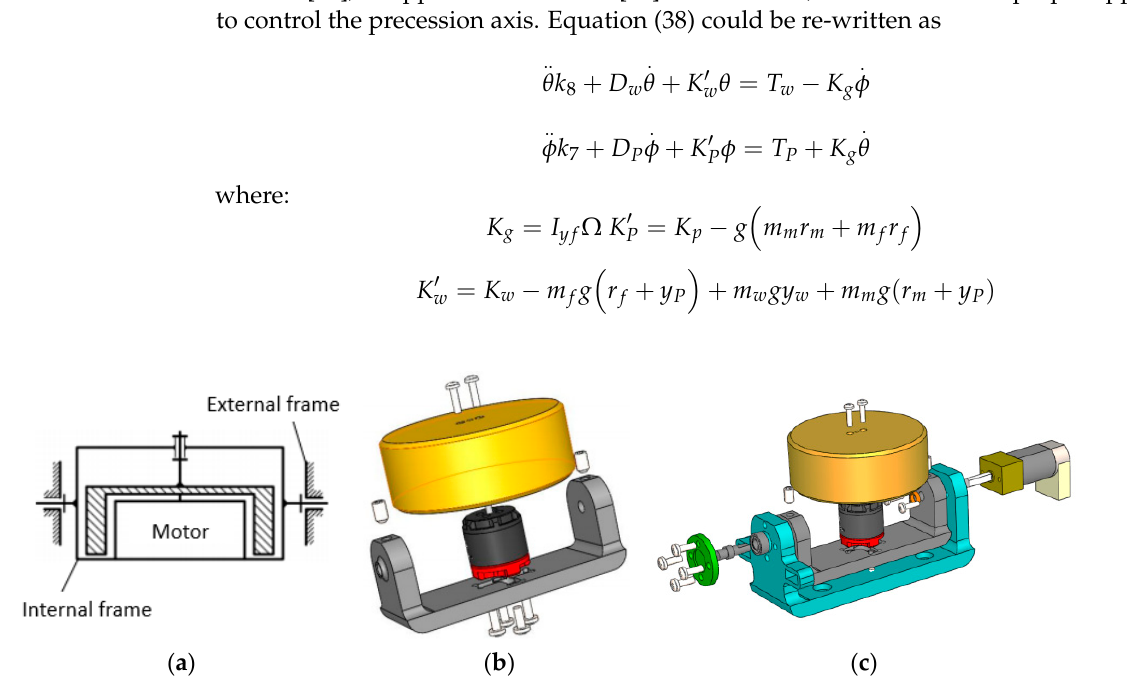
Figure 7. Theoretical design of the wearable device when the flywheel is directly attached to the motor ( a ), the internal frame of the motor–flywheel connection ( b ), and the 3D model showing the external frame and driving mechanism ( c ).